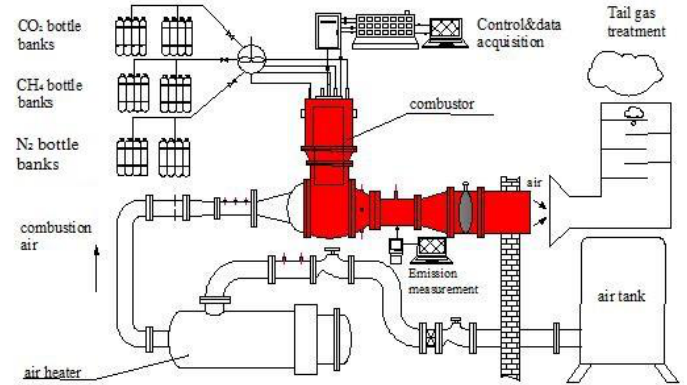
Figure 3. Structure of the test system.